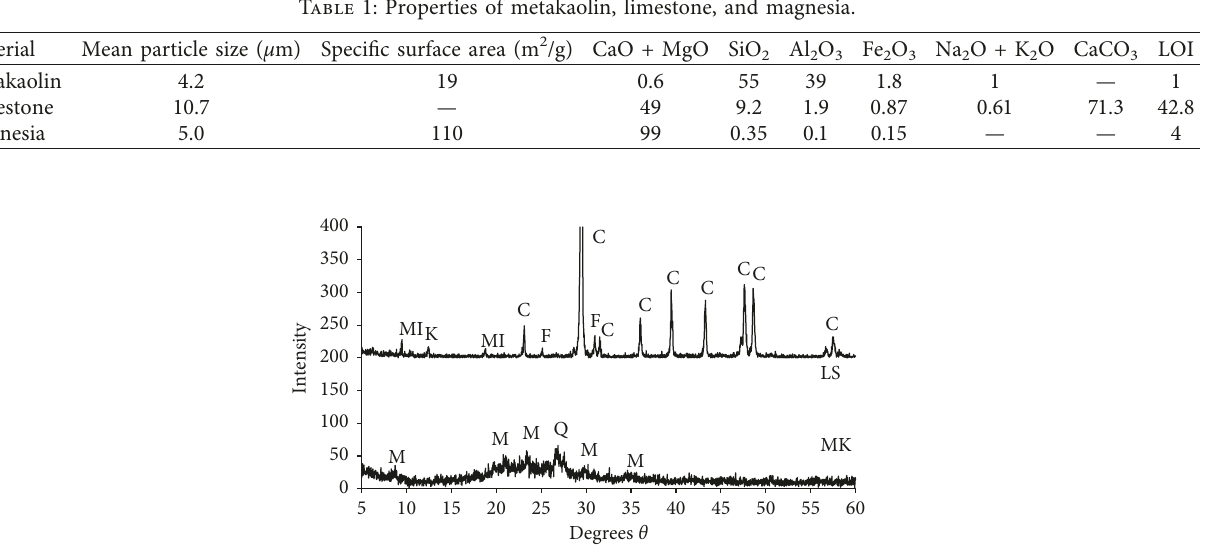
Figure 1: X-ray diffractgrams of metakaolin (MK) and limestone (LS). Phases marked are as follows: M: muscovite, Q: quartz, C: calcite, MI: mica, K: kaolinite, and F: feldspar. Table 2: Mix